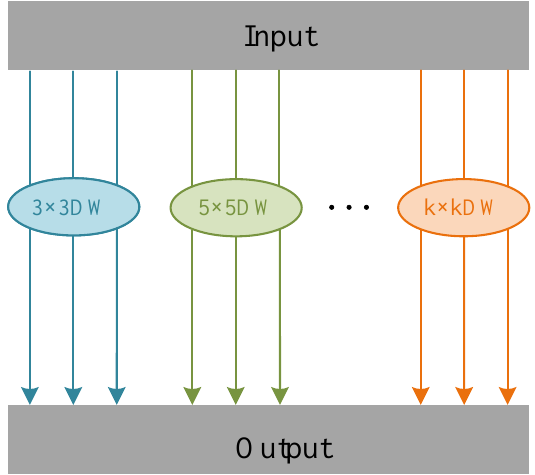
Figure 4. Schematic diagram of hybrid depth